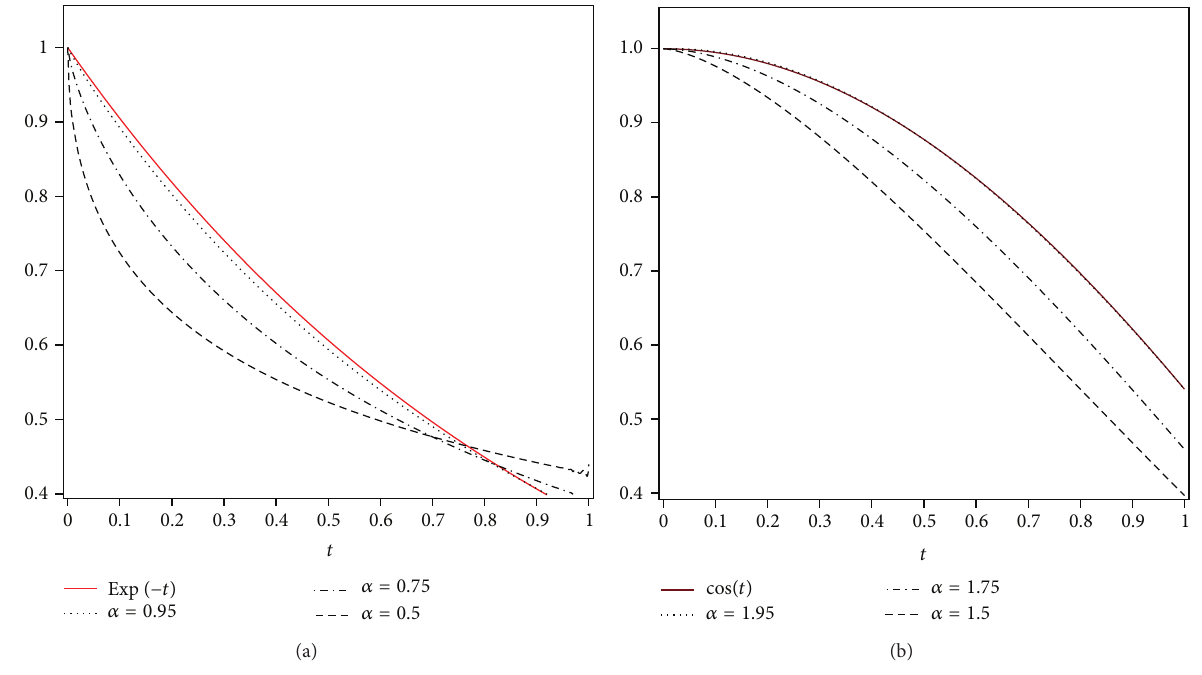
Figure 7: Comparison of 𝑦(𝑡) with (a) 𝛼 = 0.5, 0.75, 0.95, 1 , (b) 𝛼 = 1.5, 1.75, 1.95, 2 , for Example 7.